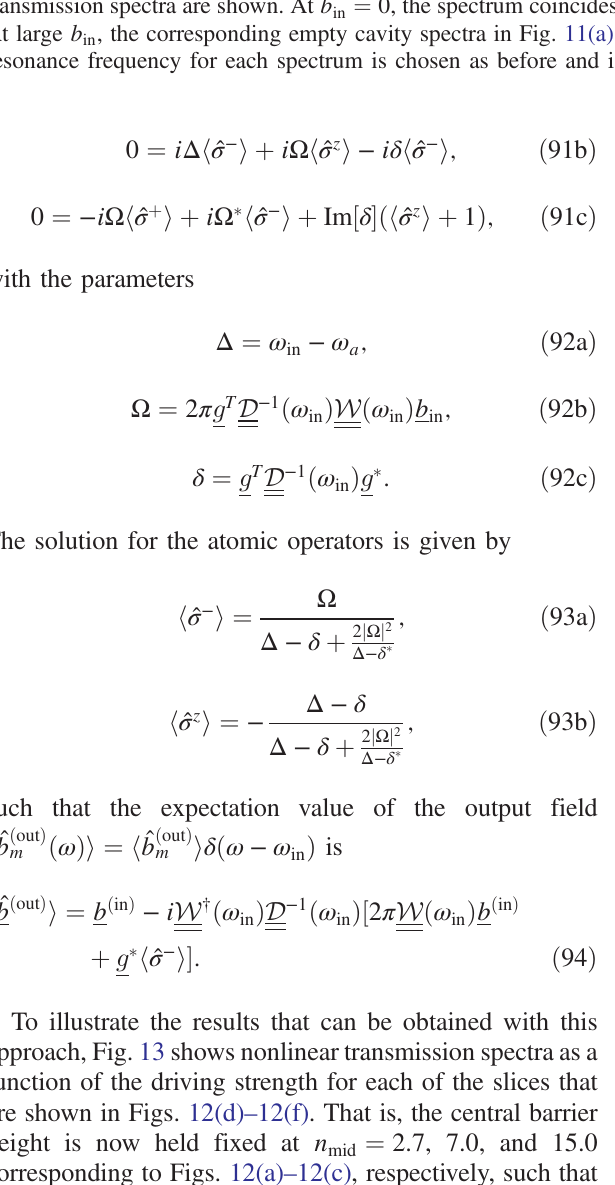
1 0 Þ , and the corresponding in ð . mid